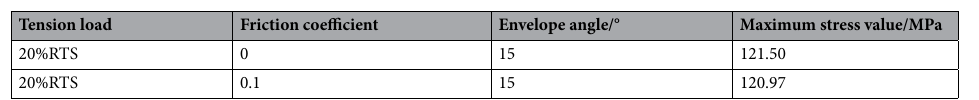
Table 7. Maximum equivalent stress of aluminum strand with or without